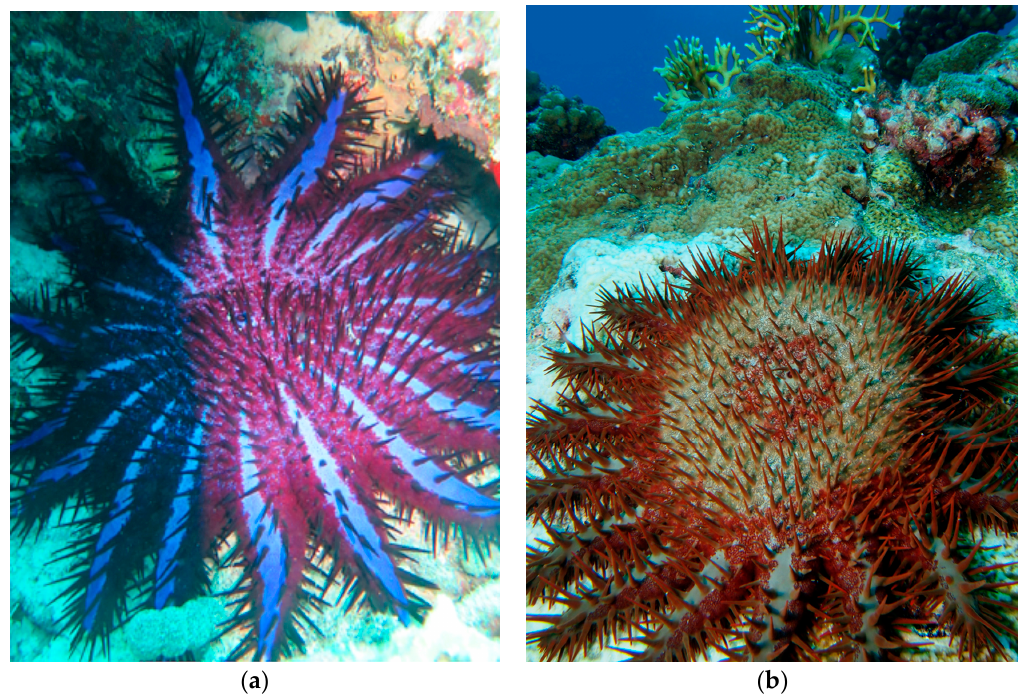
Figure 2. Distinct species of crown-of-thorns starfish: ( a ) Acanthaster planci from northern Indian Ocean (Photo taken by M. Pratchett in Maldives), ( b ) Acanthaster cf. solaris from the Pacific (Photo taken by C. Caballes in Guam).